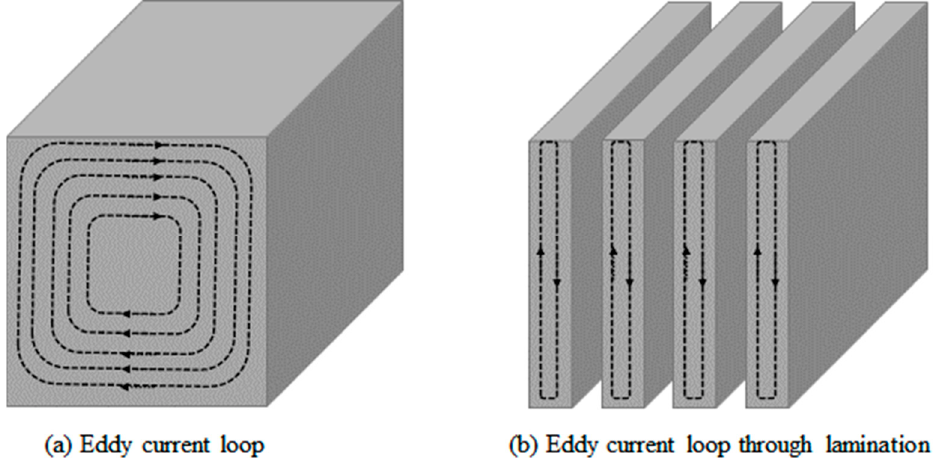
Figure 3. Example of eddy current loss path [16] ( a ) Basic eddy current loop path; ( b ) eddy current loop path through lamination.